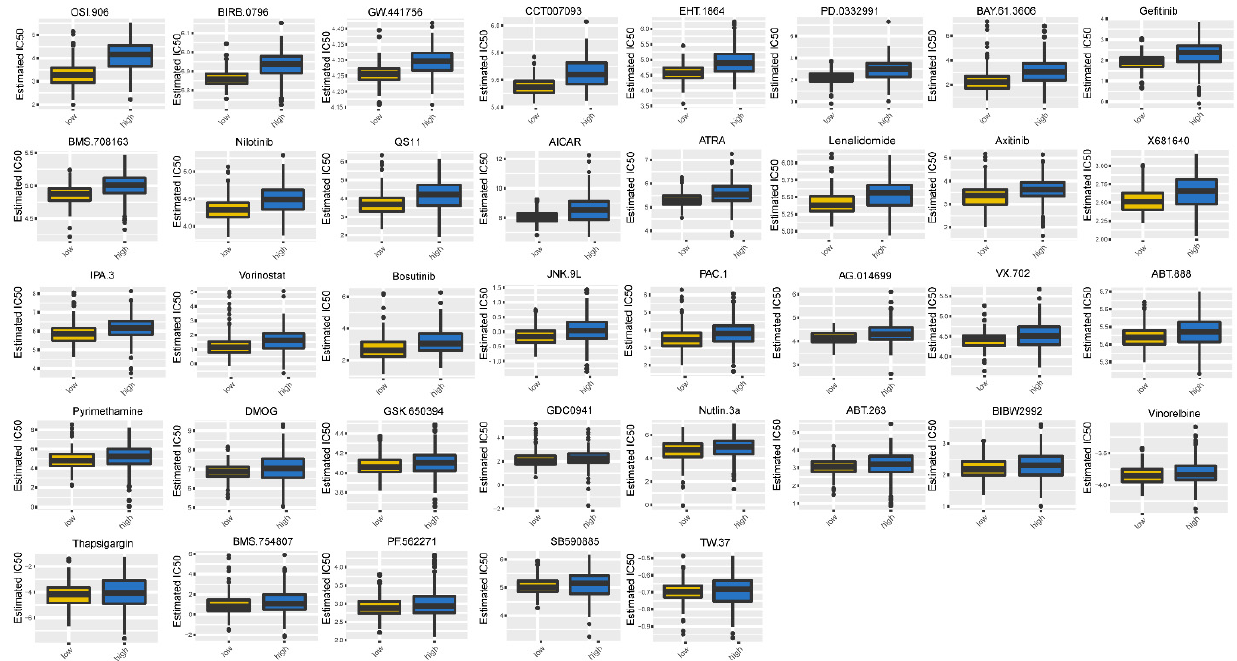
Figure 7. Chemotherapy drug sensitivity in high- and low-risk groups. * p < 0.05, ** p < 0.01, *** p < 0.001, **** p < 0.0001.